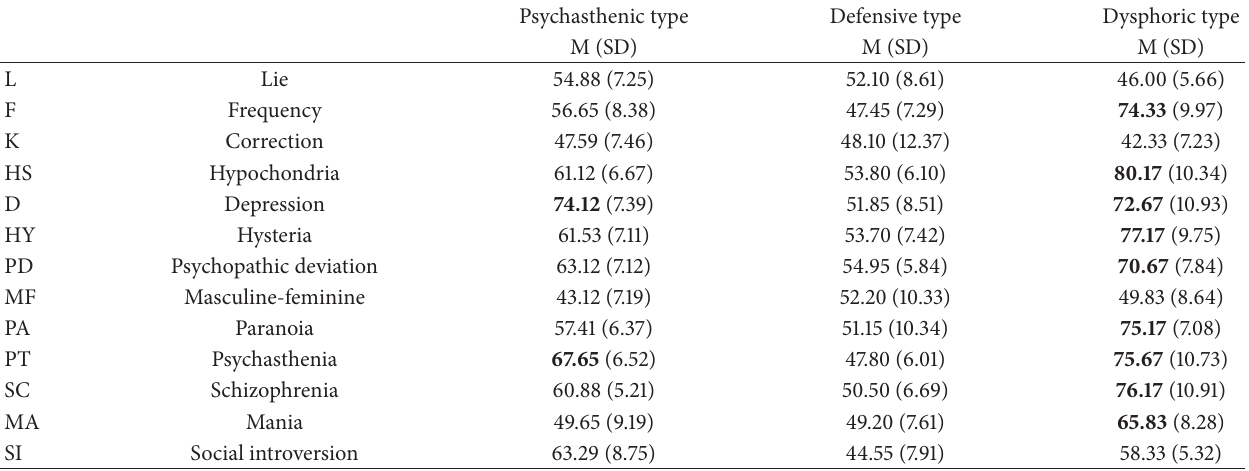
Table 2: MMPI-2 clinical scales: mean 𝑇 -scores and standard deviations of three groups compared.